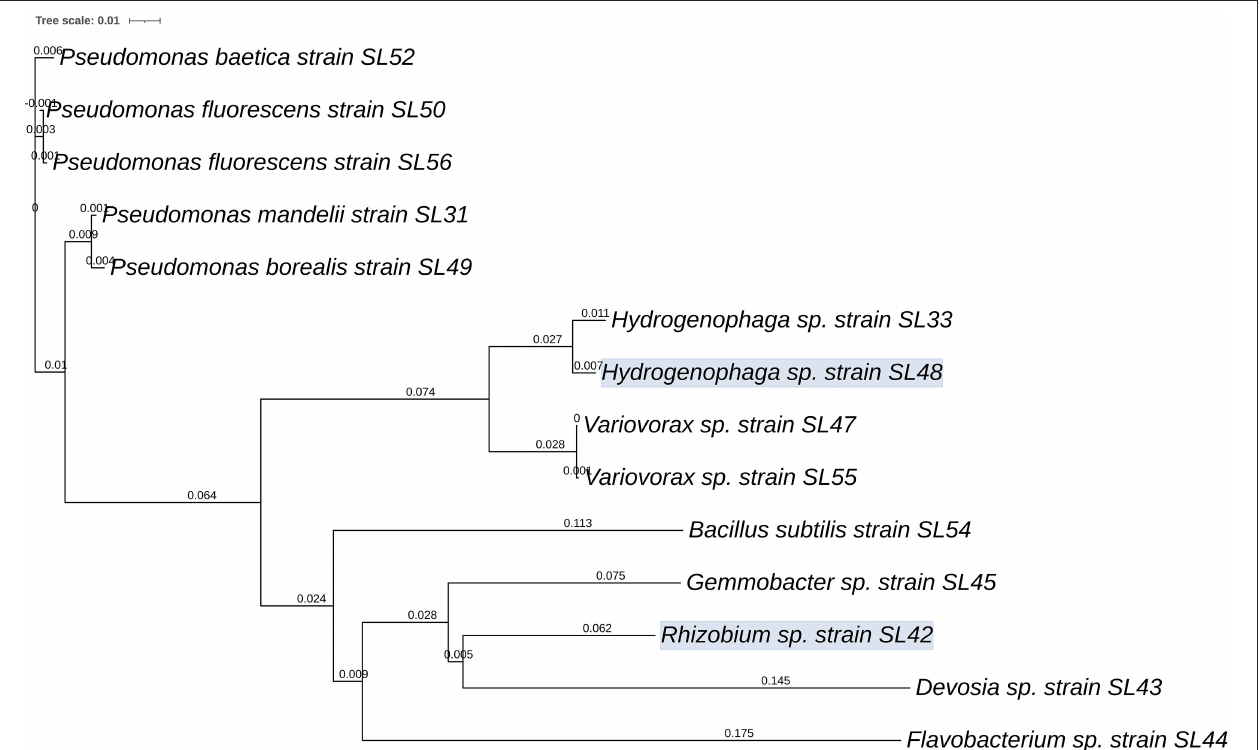
FIGURE 1 | Phylogenetic relationships between 14 bacterial strains isolated from the nodules of A. bracteata based on the 16S rRNA gene sequences. Phylogram was generated using iTOL based on the tree file from CLUSTALW2. Values on the lines indicate branch length from the node (tree: Newick/PHYLIP; kimura—false; tossgaps—off; Clustering—Neighbor joining; percent identity